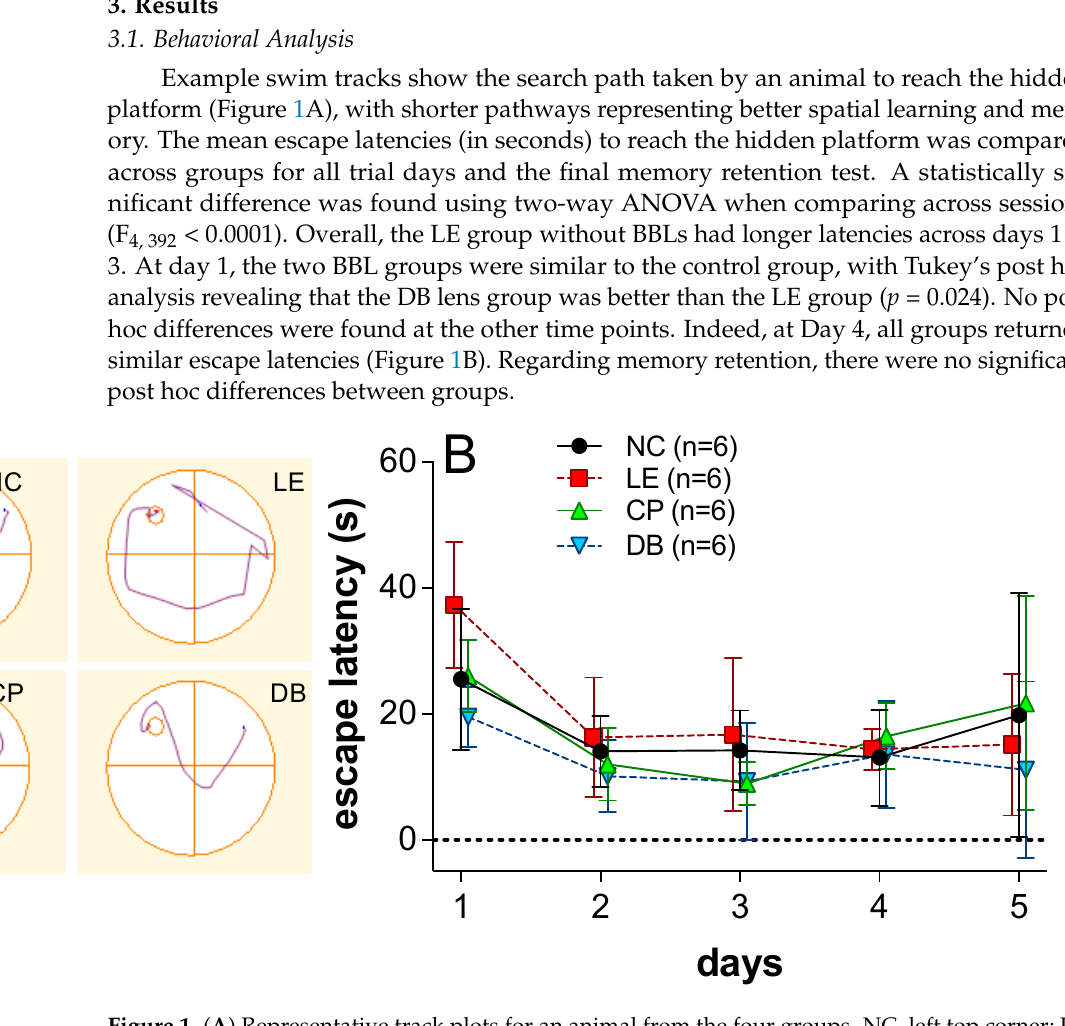
Figure 1. ( A ) Representative track plots for an animal from the four groups. NC, left top corner; LE, right top corner; CP, left bottom corner; and DB, right bottom corner (right side). ( B ) Group ( ± SD) escape latency (s) on the 5 consecutive trial two-way ANOVA indicated a significance difference ( p < 0.05) on day 1 to day 3, but not days 4 or